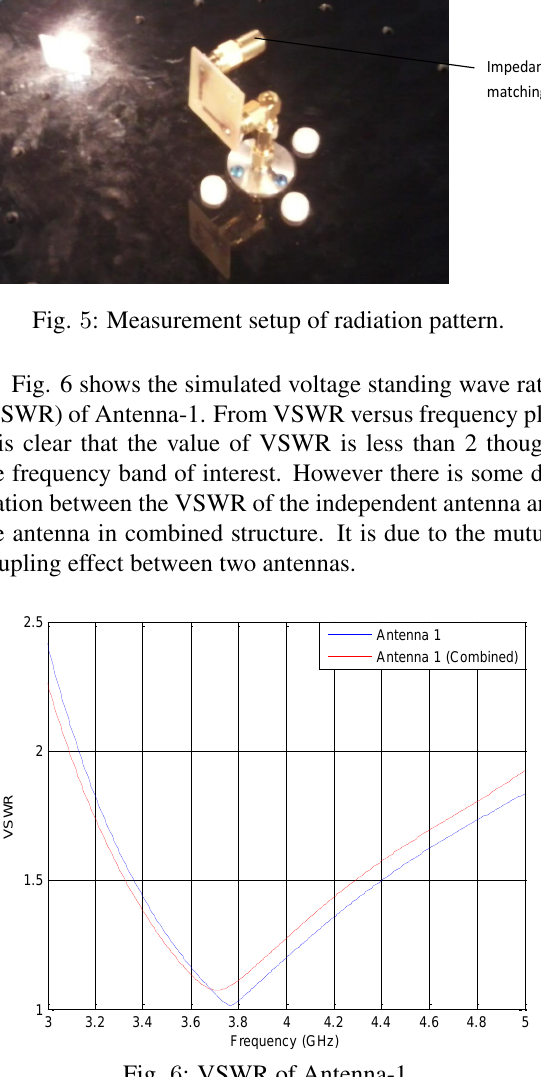
Impedance matching pad